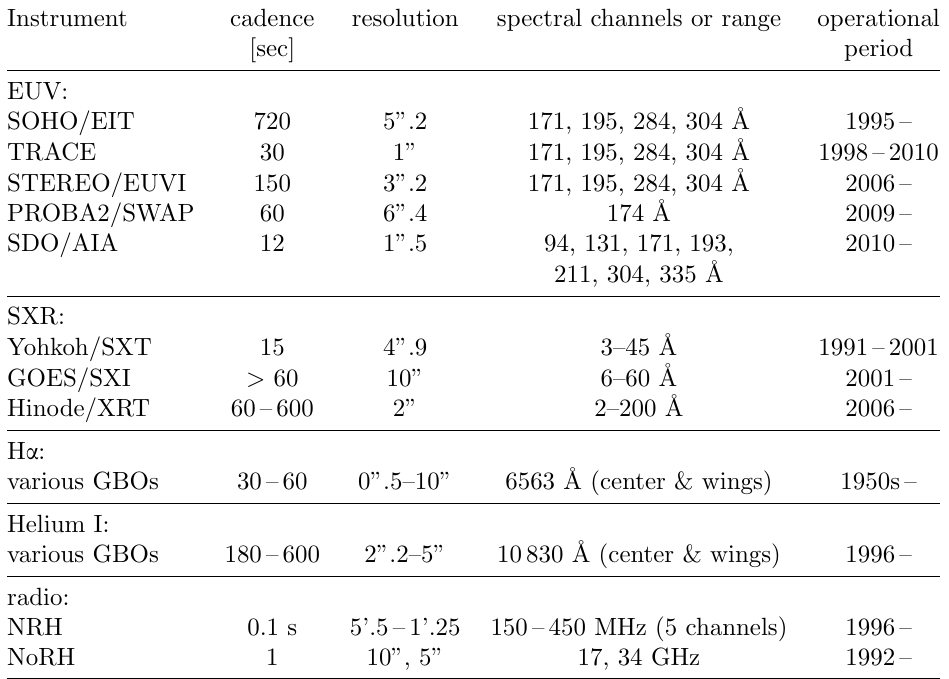
Table 1: Instruments that have imaged signatures of coronal waves. Typical parameters are listed. Instrument